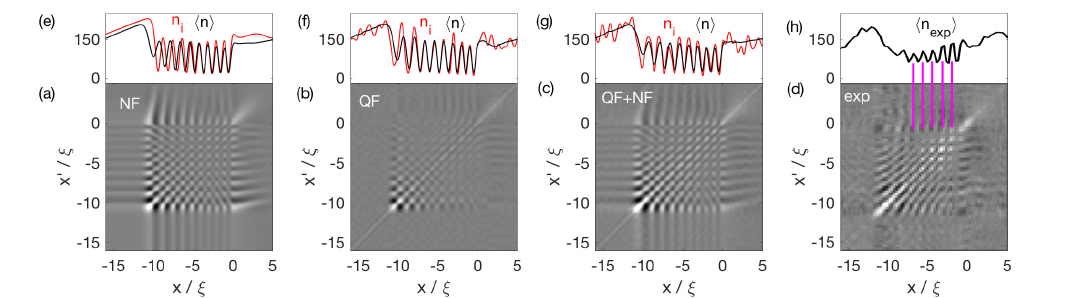
Figure 3: The density-density correlations at t = 120 ms by (a) number fluctuations, (b) quantum fluctuations, and (c) both. (d) experimental density-density correlation taken from [ 3 ] . Note that for panels (a) and (c), the number of condensate atoms fluctuates about ∆ N / ¯ N = 0.05. Top panels (e-g) are the profiles of the averaged density 〈 n ( x ) 〉 (black) and ( x ) (red). Panel (h) is the ensemble that of one realization in the corresponding ensemble , n i 〉 , taken from [ 3 ] average of experimental density, 〈 n exp